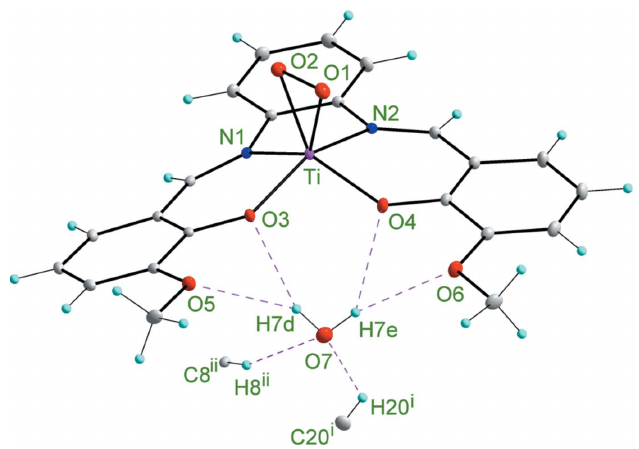
Figure 1 ORTEP plot of the title compound. Thermal ellipsoids are drawn at 30% probability. Symmetry codes used: (i) x , (cid:3) 1 + y , z ; (ii) 1 (cid:3) x , 1 (cid:3) y , 1 (cid:3) z